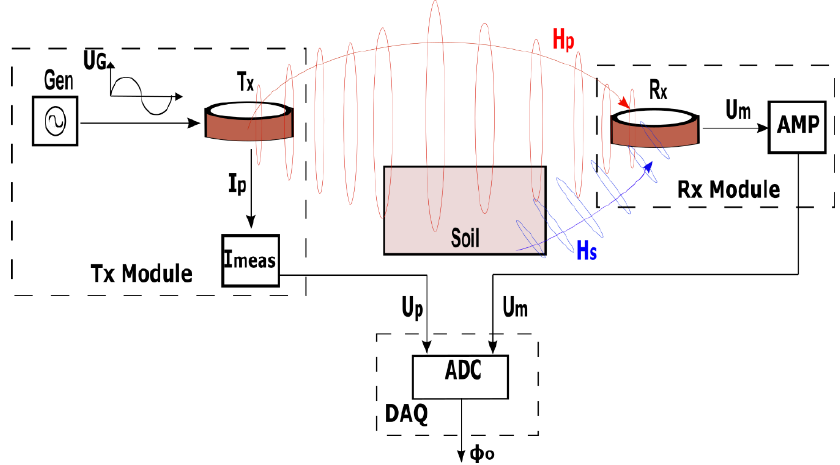
Figure 3. Signal flow diagram for the EMI measurement system for a single Tx – Rx arrangement.